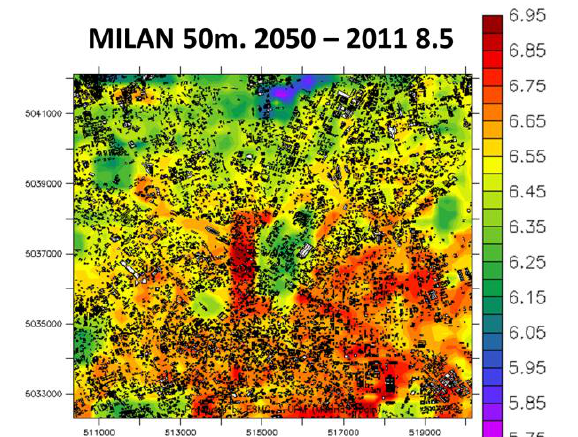
Figure 2. Yearly average of spatial distribution of the differences (%) mortality for natural causes due to air pollution and temperature for 2050 respect to 2011 following RCP 4.5 (top) and RCP 8.5 (bottom) scenarios with WRF-Chem-MICROSYS over Milan with 50 m. spatial resolution.